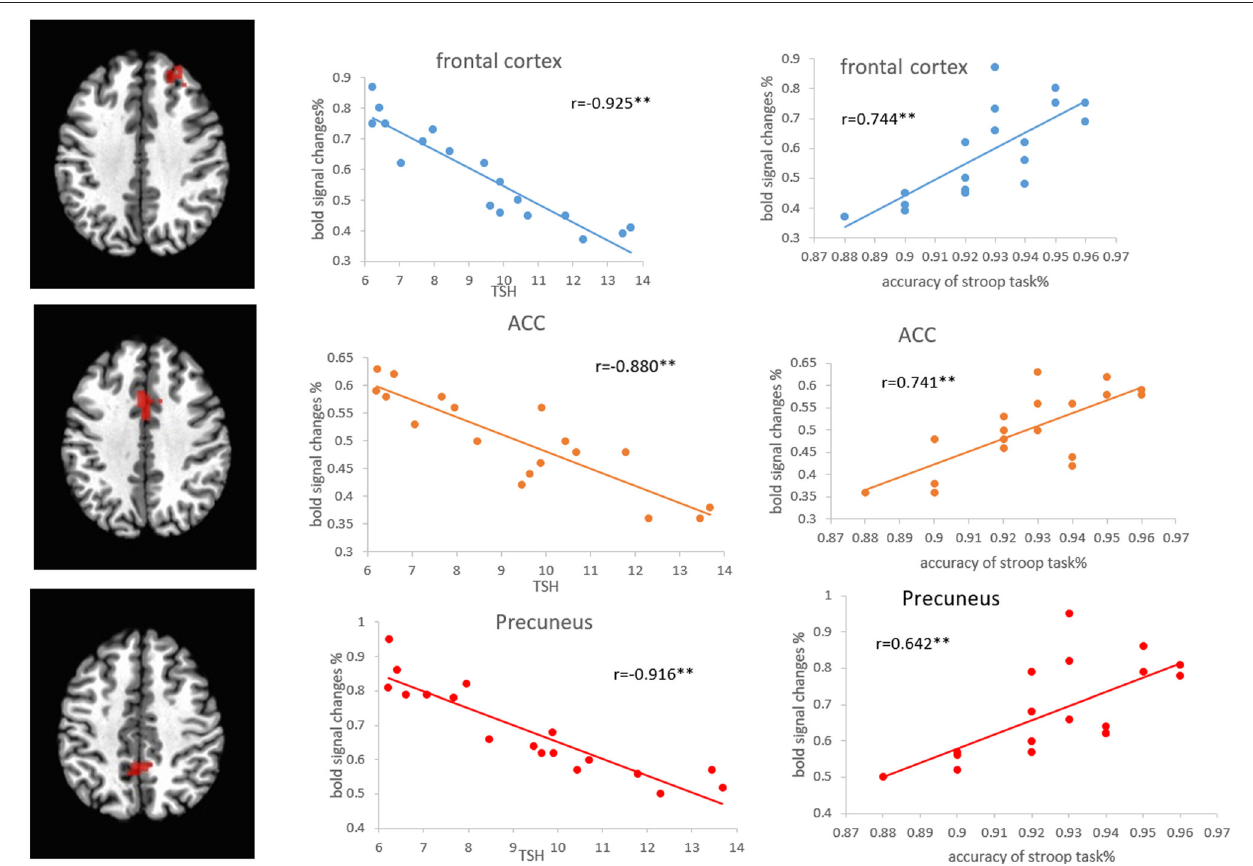
FIGURE 7 | Correlations between the percentage of BOLD signal changes in the frontal cortex, ACC, and precuneus, and the Stroop task and TSH level in patients with SCH. ACC, anterior cingulate cortex; SCH, subclinical hypothyroidism; TSH, thyroid-stimulating